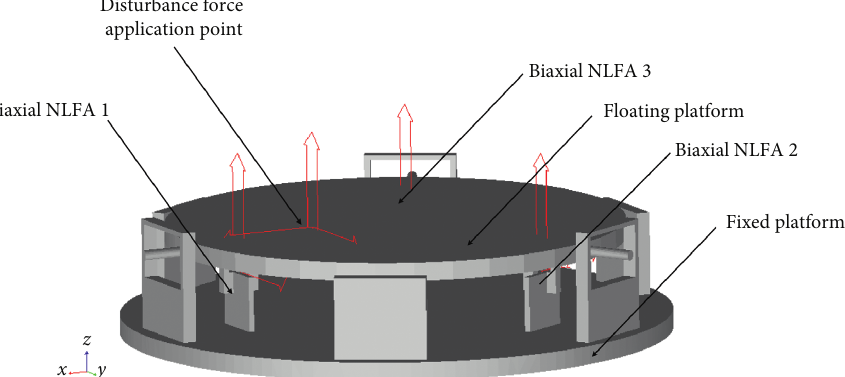
Figure 2: Simulation model of mechanical system in ADAMS.